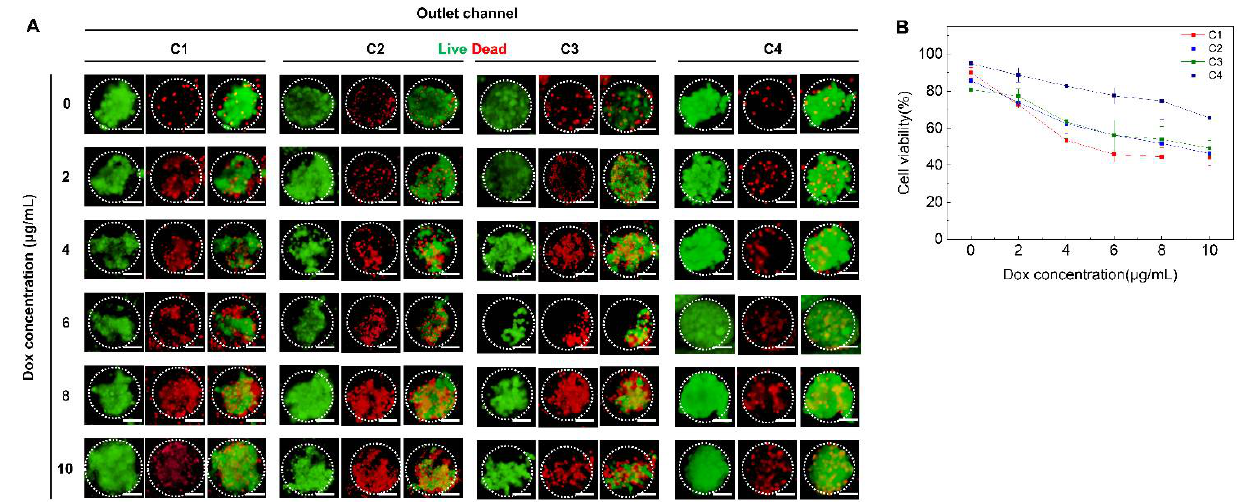
Figure 4. Spheroid generation after 1 day encapsulation. ( A ) Spheroid image after Dox treatment (live and dead cells were stained with Calcein-AM and EthD-1, respectively). Scale bars are 100 μm. ( B ) Cell viability with respect to Dox concentrations.